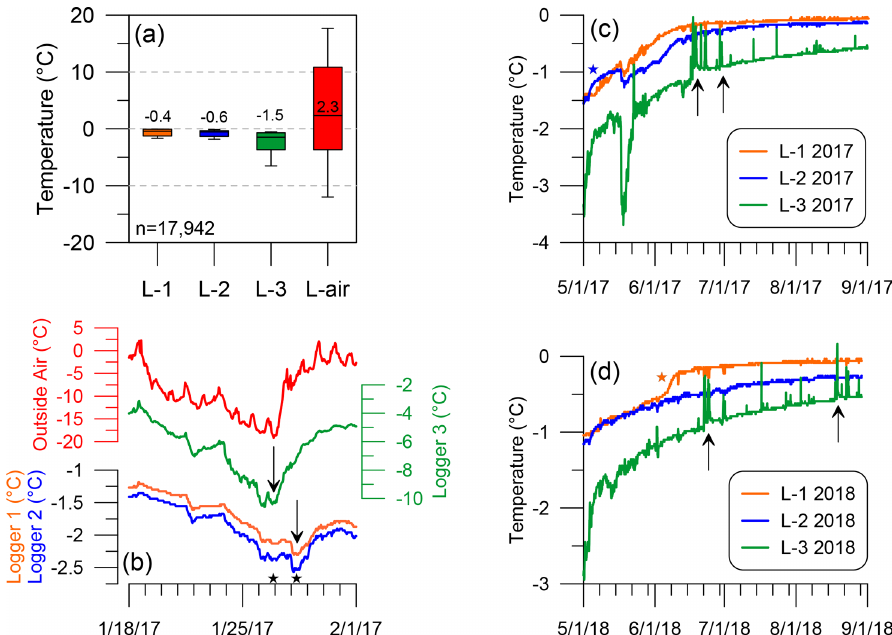
Figure 4. Details of temperature records from Winter Wonderland Cave. (a) Box-and-whisker plot showing the distribution of temperature measurements at each of the three loggers (L-1 through L-3) as well as outside the cave. (b) Detailed view of temperature records from late January 2017. A notable low point in temperature outside the cave was mirrored immediately by a temperature drop within the Icicle Room, recorded by Logger 3 on 27 January (star). A corresponding drop in the temperature deeper in the cave was recorded 2d later (second black arrow and star), supporting the theory that cold air enters through the Icicle Room in winter. (c, d) Temperatures during the summer of 2017 (c) and in the summer of 2018 (d) at the loggers within the cave. The black arrows highlight examples of transient warming in the Icicle Room that were not observed deeper in the cave. The blue star in (c) marks an interval in early May, when the temperature at Logger 2 in the Frozen Freeway briefly rose above the temperature of Logger 1 at the Skating Rink. The orange star in (d) highlights a dramatic, permanent increase in temperature at Logger 1, interpreted to represent the arrival of meltwater at the back of the cave in 2018.